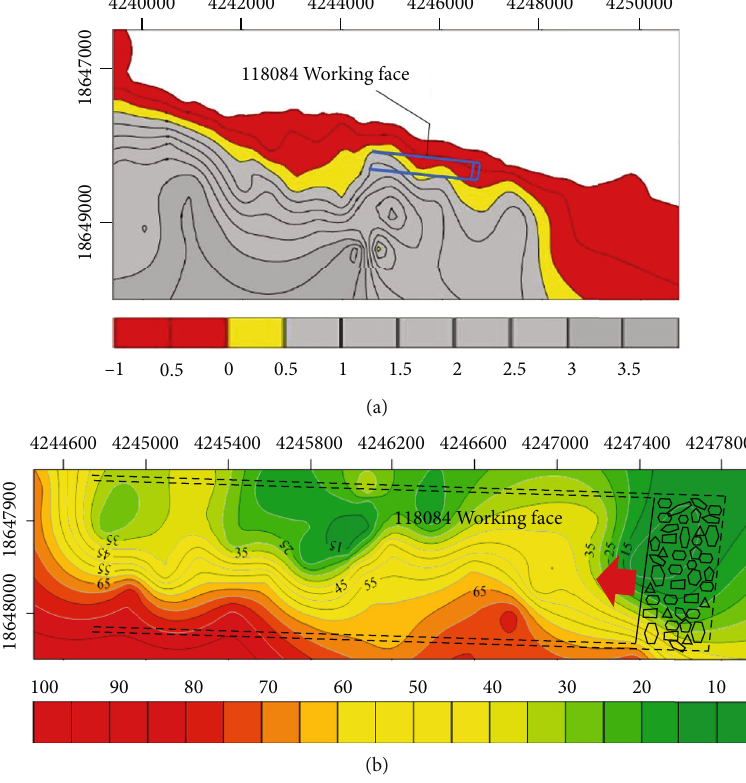
Figure 11: Contour map of water inrush possibility of #111084 working face.